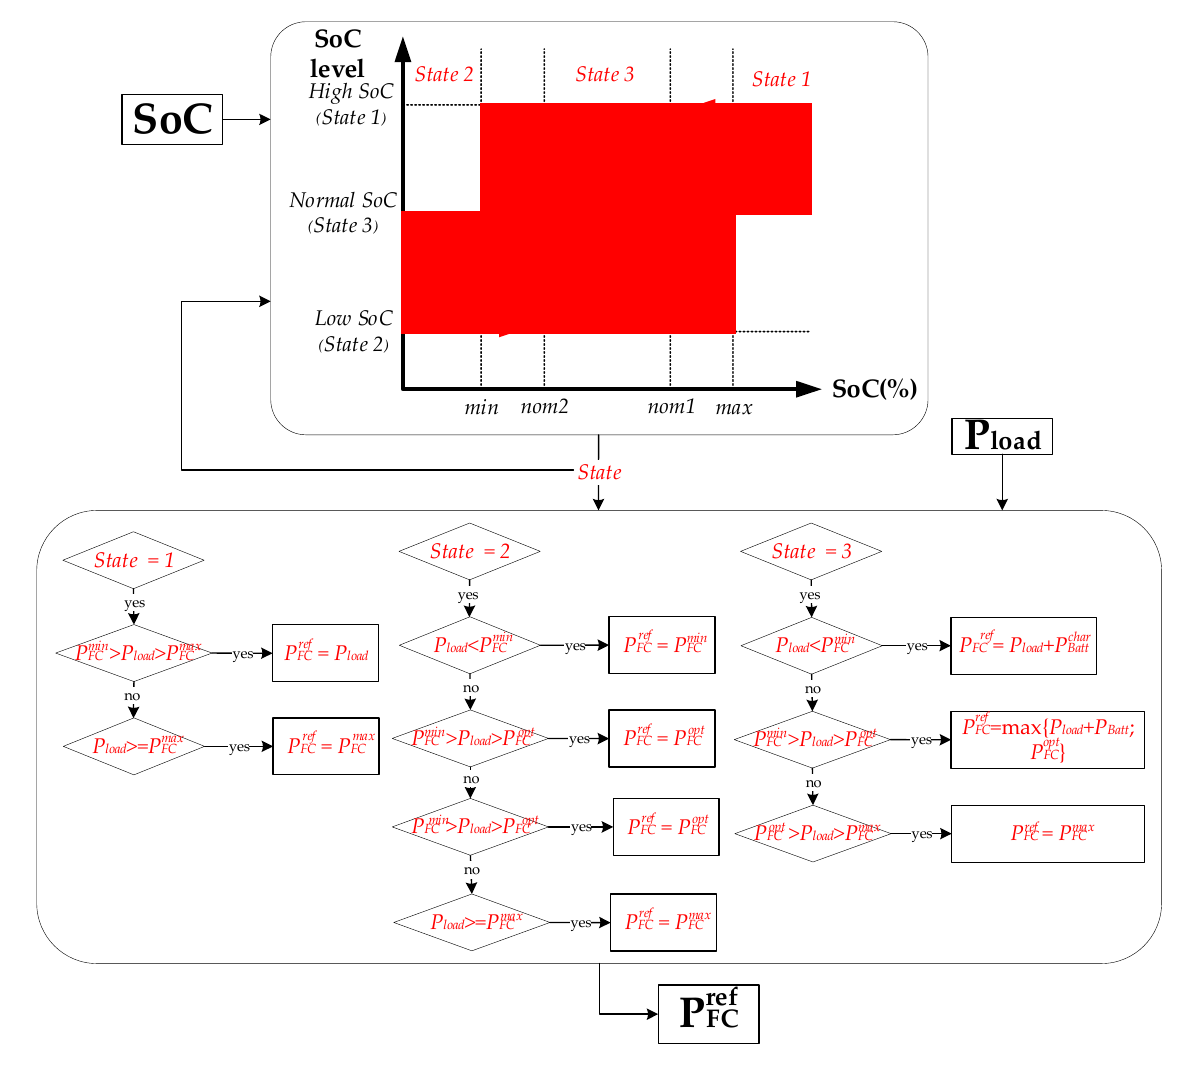
Figure 8. The scheme of SMC control.